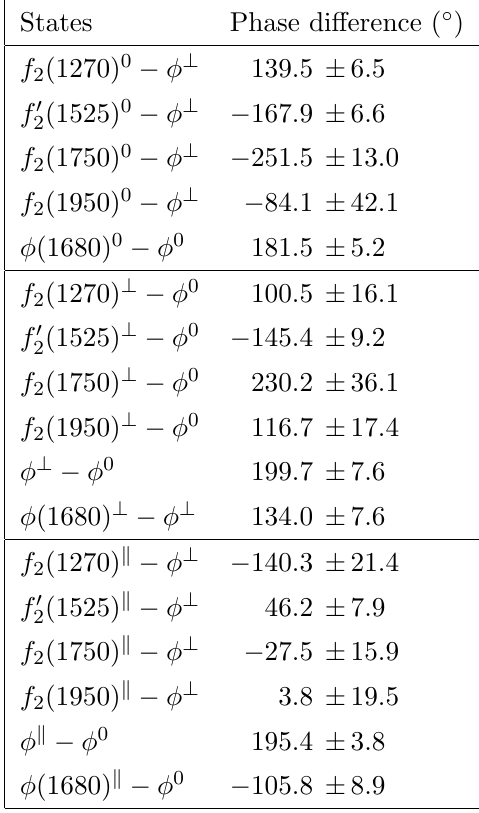
Table 4 . Fitted phase di(cid:11)erences between two transversity states (statistical uncertainty only). Here the symbol (cid:30) refers to the components of the (cid:30) (1020) meson.